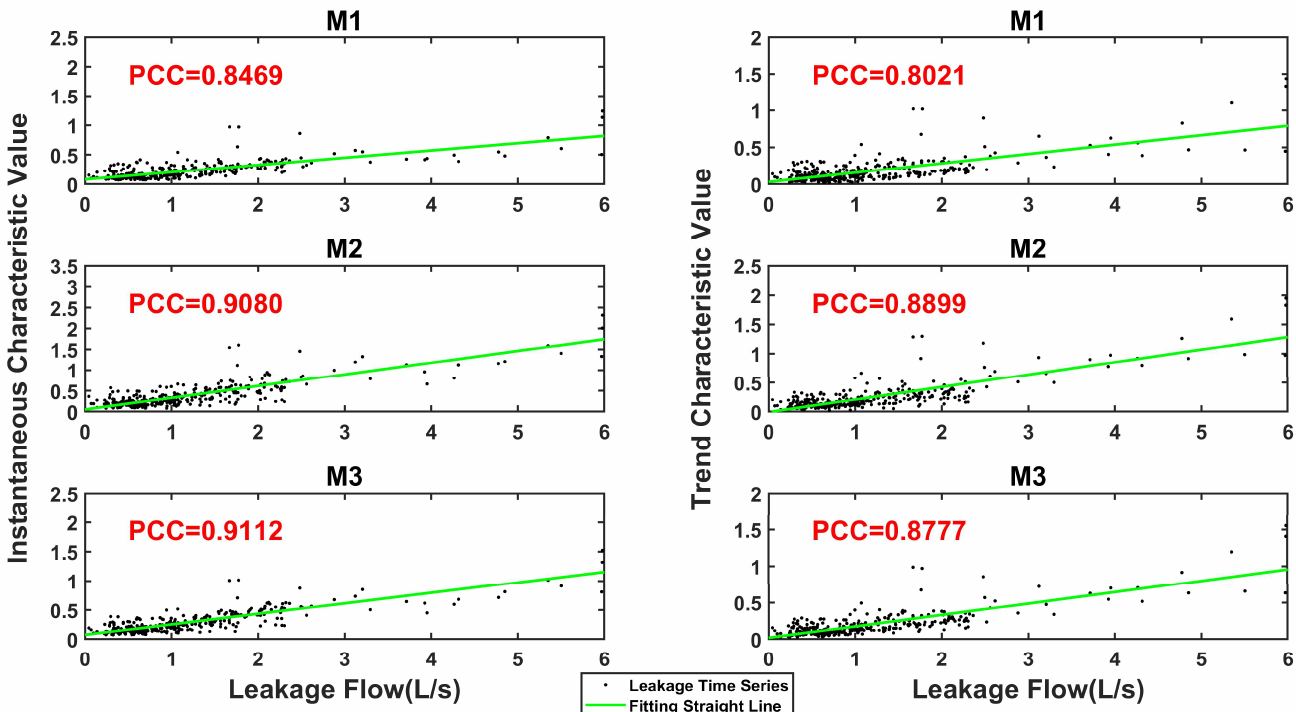
Figure 7. Relationships between characteristic values of leakage events and leakage flow in the steady-state time series data set.